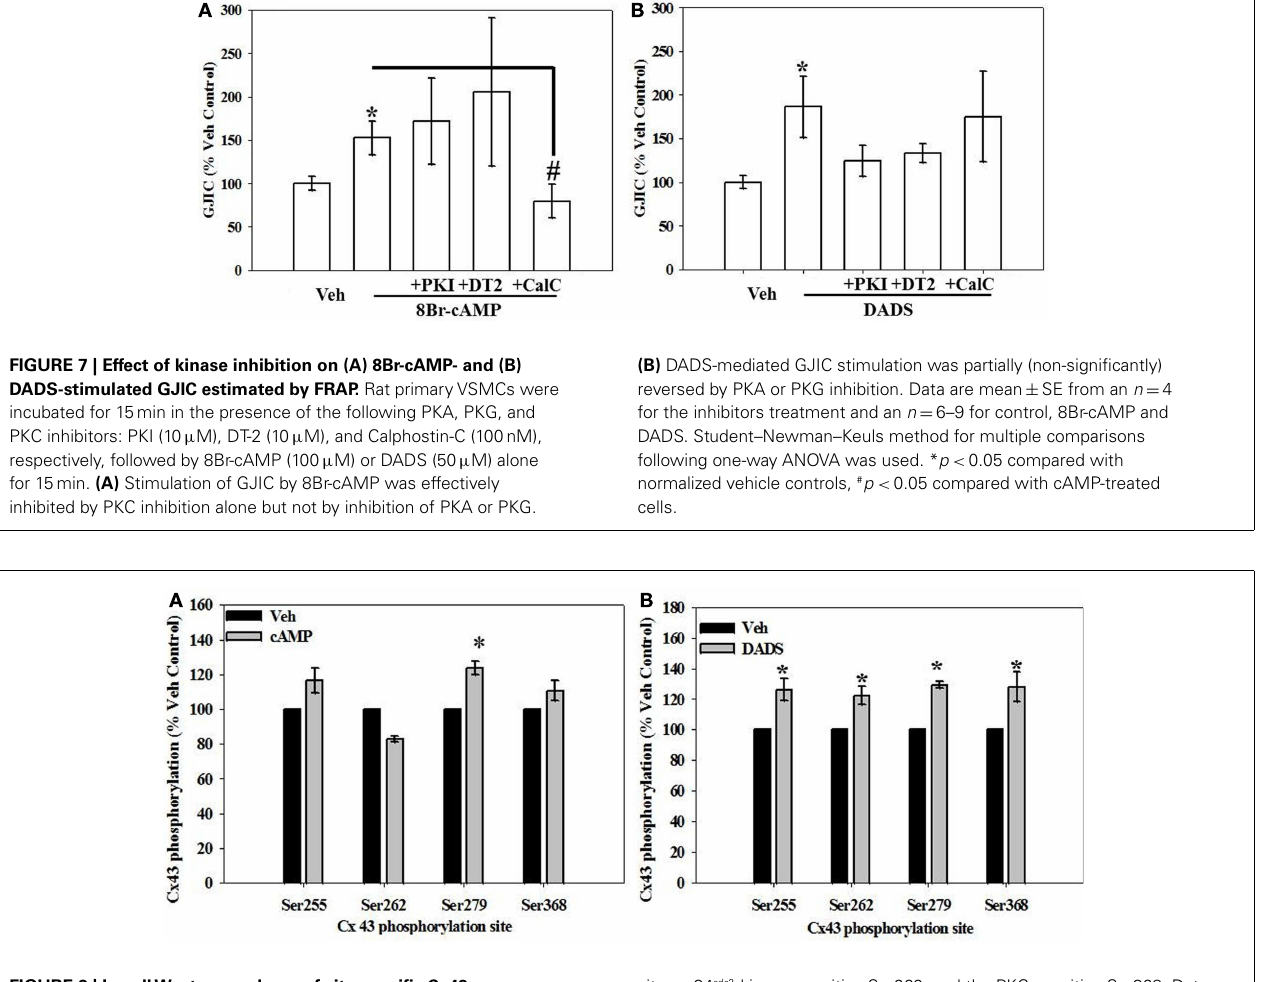
FIGURE 8 | In-cellWestern analyses of site-specific Cx43 phosphorylation in rat primaryVSMCs in the presence of (A) 8Br-cAMP and (B) DADS. (A) In the presence of 8Br-cAMP, phosphorylation of the MAPK-sensitive Ser279 was significantly increased compared to vehicle controls. (B) The presence of DADS significantly increased phosphorylation at the MAPK sensitive Ser255 and Ser279